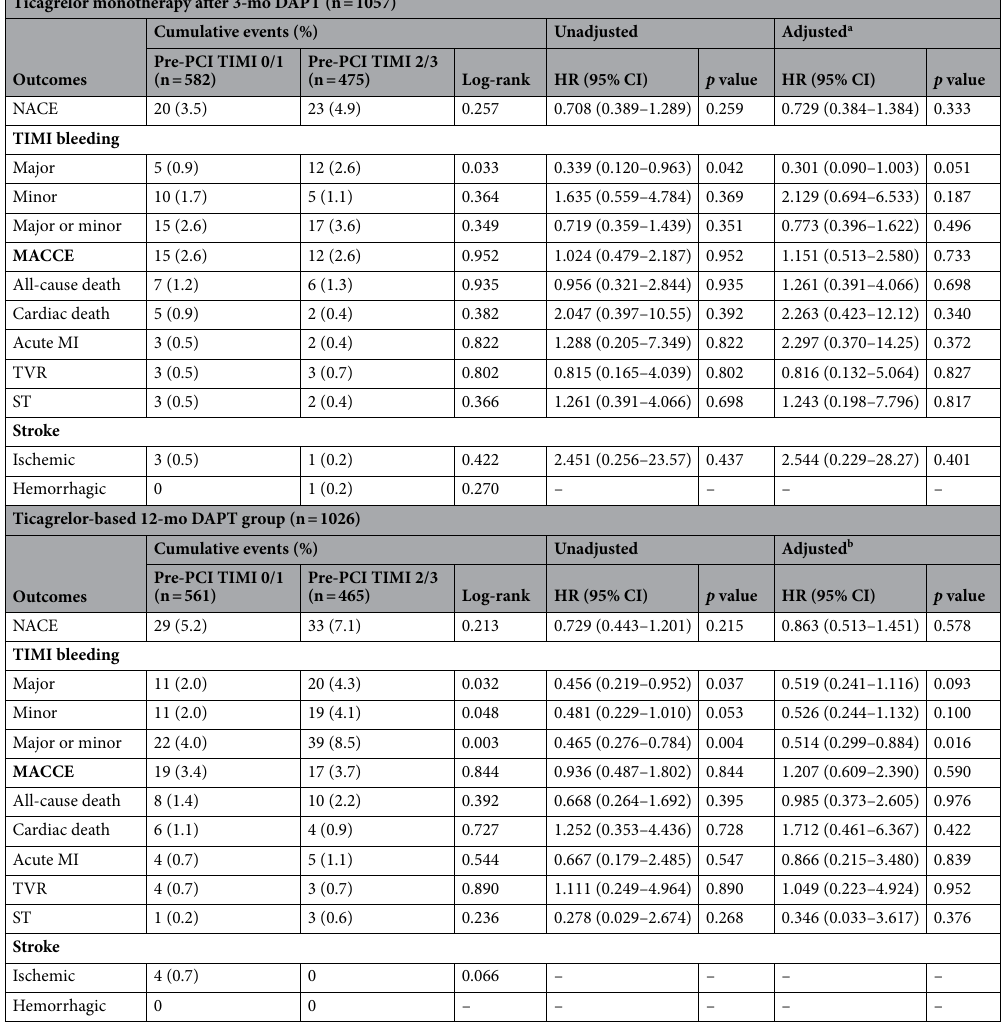
Table 3. Clinical outcomes between pre-PCI TIMI 0/1 and 2/3 groups according to 3-month or 12-month DAPT strategies. Pre-PCI pre-percutaneous coronary intervention, TIMI Thrombolysis In Myocardial Infarction, DAPT dual antiplatelet therapy, HR hazard ratio, CI confidence interval, NACE net adverse clinical events, MACCE major adverse cardiac and cerebrovascular events, MI myocardial infarction, TVR target vessel revascularization, ST stent thrombosis, LVEF left ventricular ejection fraction, STEMI ST-segment elevation myocardial infarction, LM left main coronary artery, ACE angiotensin converting enzyme, CCB calcium channel blocker. a Adjusted by age, LVEF, diabetes mellitus, white blood cell, hemoglobin, STEMI, LM, and single-vessel disease (Supplementary material 16). b Adjusted by age, male, hypertension, diabetes mellitus, prior MI, prior PCI, hemoglobin, STEMI, beta-blocker, ACE inhibitor, CCB, transfemoral approach, and stent diameter (Supplementary material